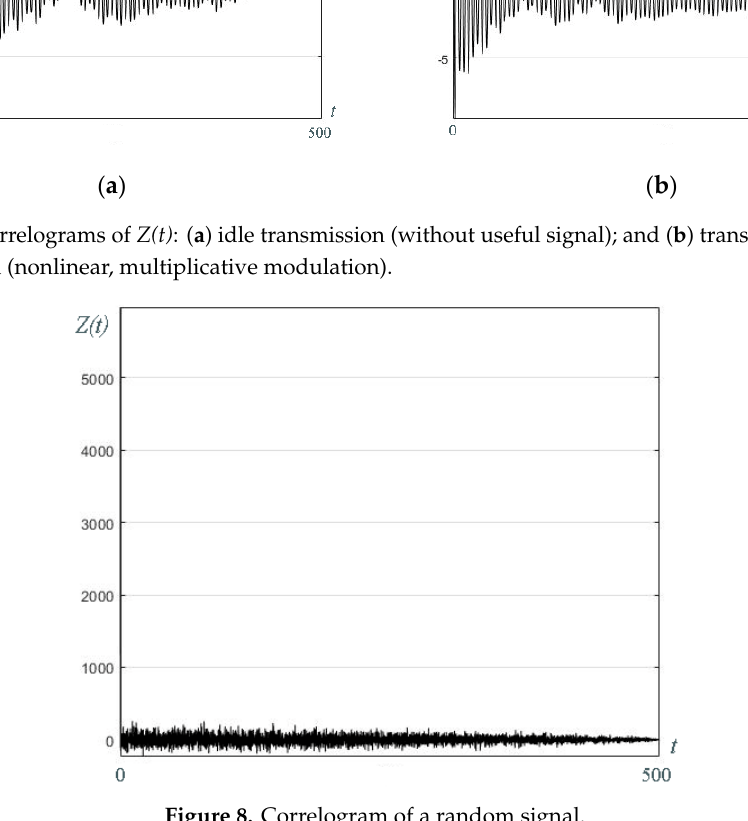
Figure 8. Correlogram of a random signal.